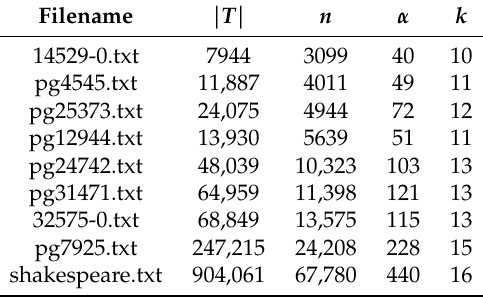
n is given in Figure α and log 2 2